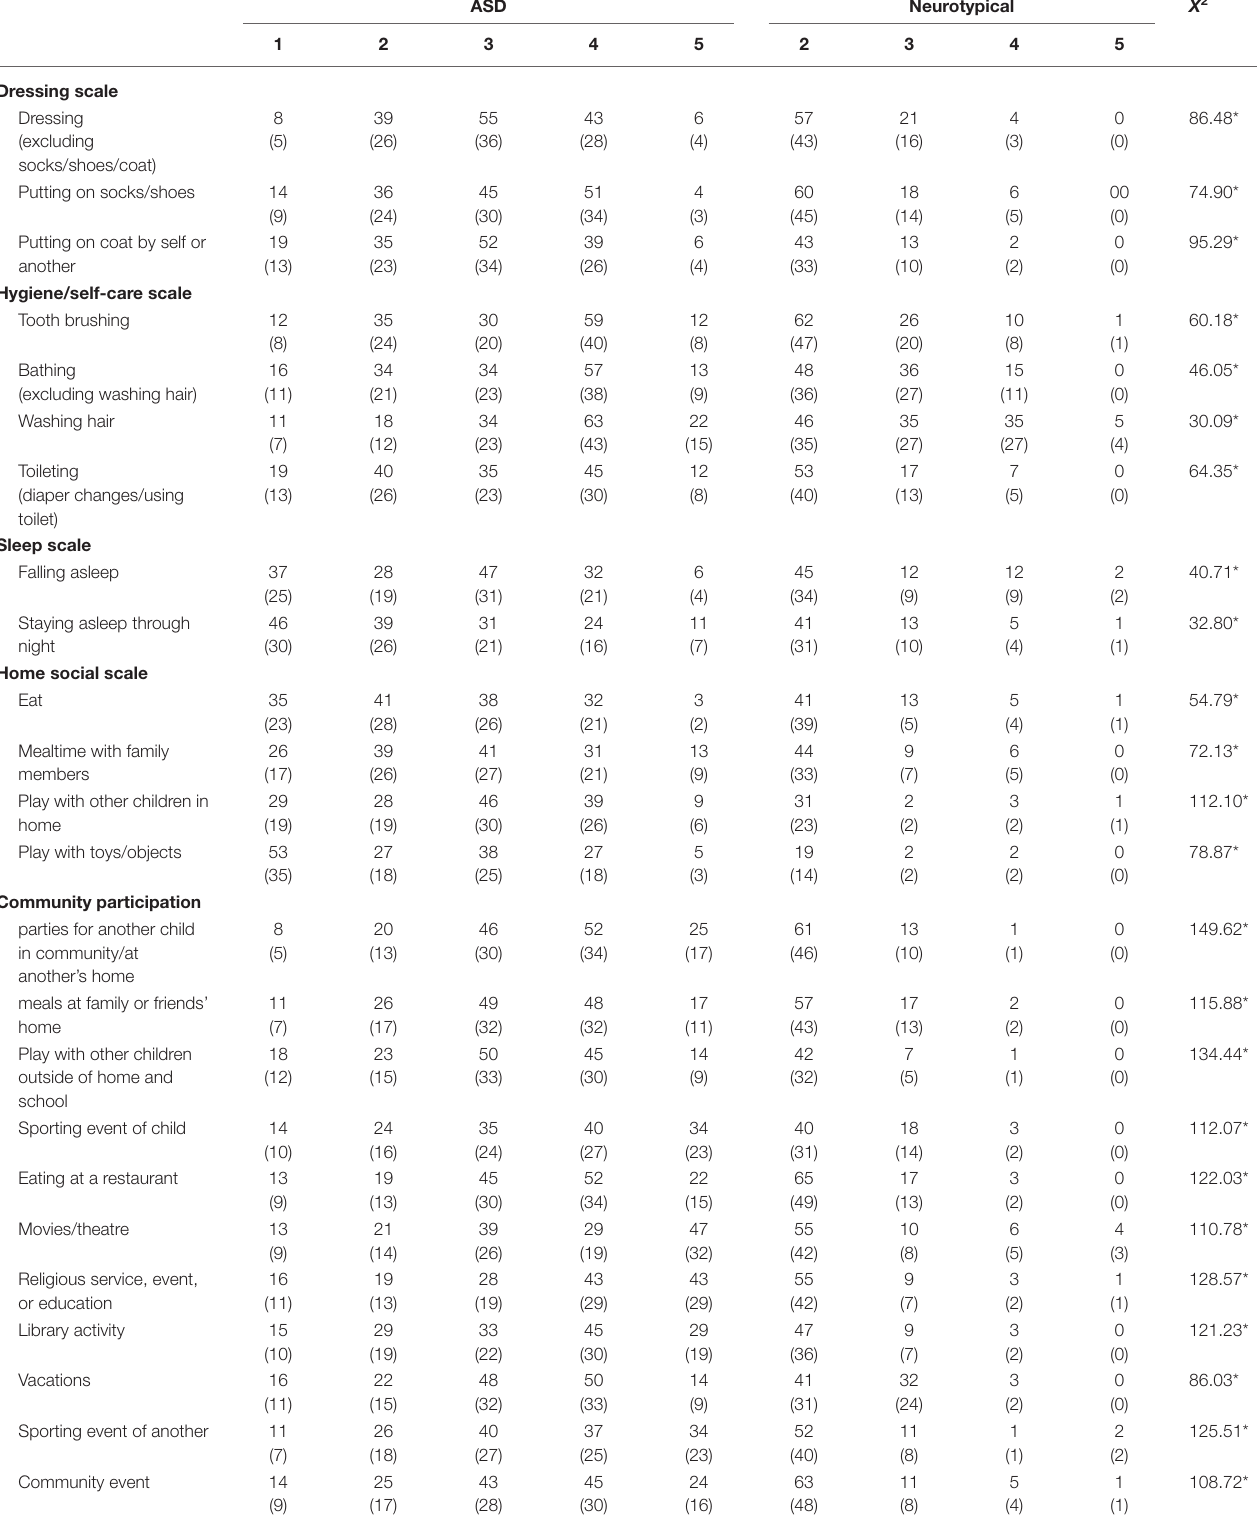
TABLE 2 | Parent Effort Scale (PES) item response frequencies, n (%).